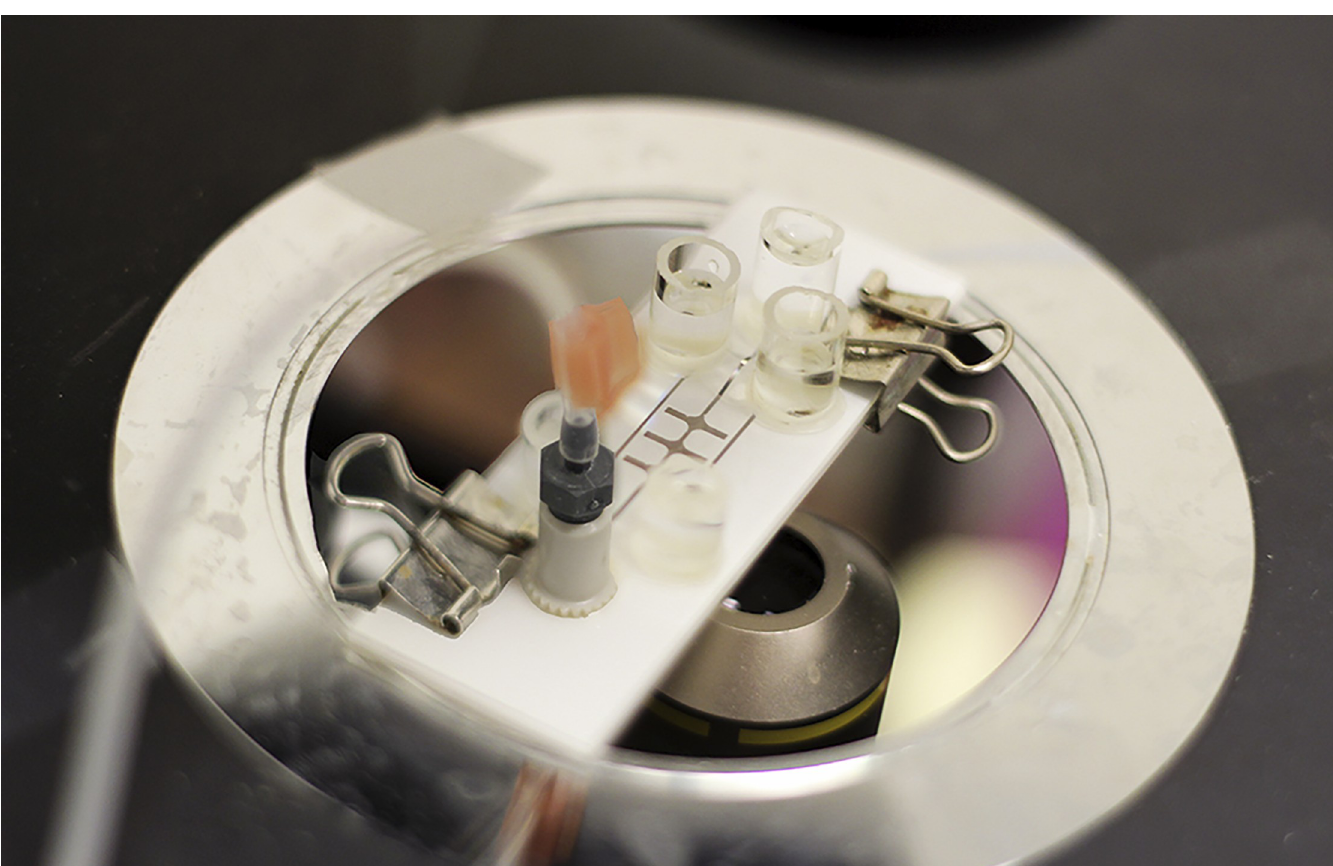
Fig 2. Microfluidic assembly on the stage of the microscope. A syringe pump was used to control the flow rate of the Euglena suspension. The Euglena sample was added in the reservoir on the right end of the central channel and pulled through the microfluidic system using a syringe pump connected on the